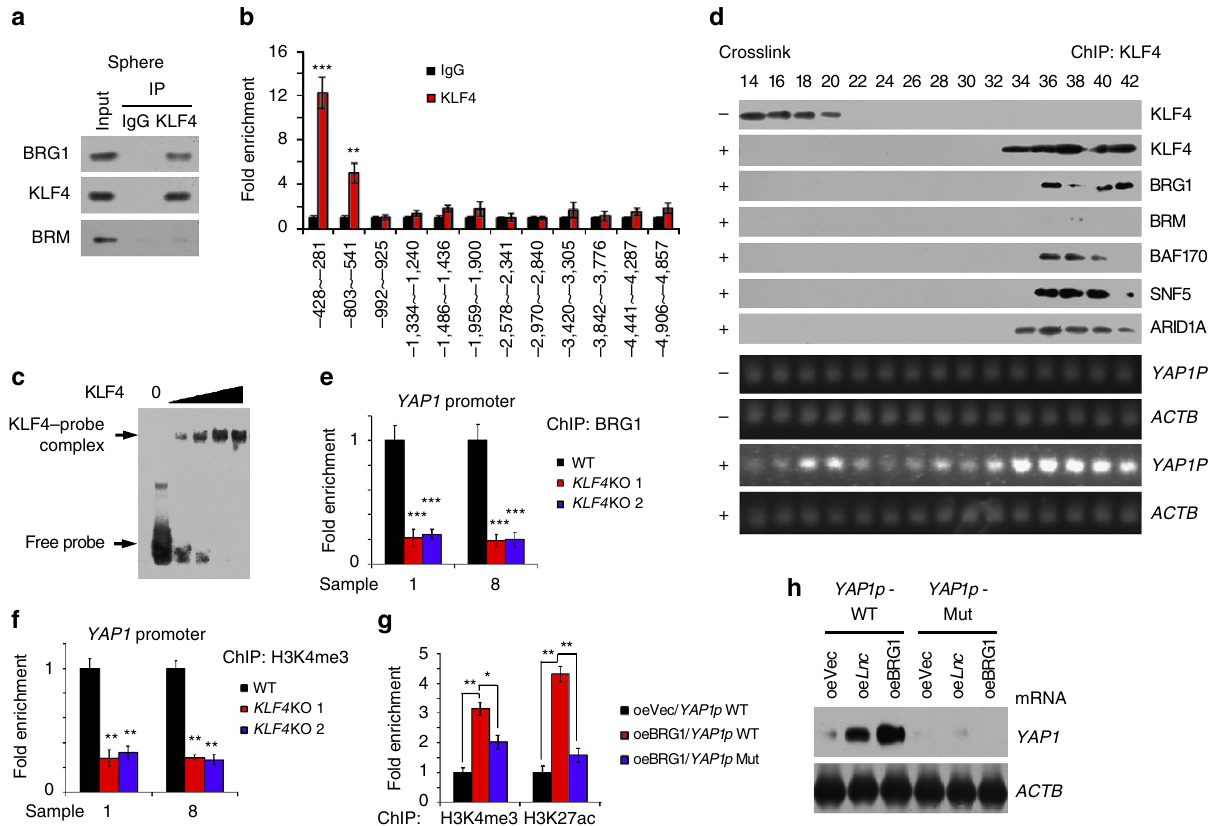
Figure 5 | KLF4 binds YAP1 promoter and recruits the BRG1-embedded BAF complex to initiate YAP1 expression. ( a ) HCC primary spheres were collected for co-IP assays with KLF4 antibody. ( b ) ChIP assay was performed using Klf4 antibody. ( c ) The interaction of KLF4 with YAP1 promoter was verified by EMSA assay. ( d ) HCC primary sphere cells were crosslinked with formaldehyde for ChIP assay with KLF4 antibody, followed by glycerol gradient ultracentrifugation. Elution gradients were concentrated for western blotting (upper panels) and PCR (lower panels) analyses. ( e , f ) KLF4 KO cells were established using CRISPR/Cas9 technology and allowed for sphere formation, followed by ChIP assay using BRG1 ( e ) and H3K4me3 ( f ) antibodies. ( g ) BRG1 was overexpressed in YAP1 promoter mutant ( YAP1p Mut) and wild-type (WT) cells, followed by sphere formation. Oncosphere cells were used for ChIP assays with H3K4me3 and H3K27ac antibodies, followed by examination for YAP1 promoter enrichment with real-time PCR. ( h ) LncBRM or BRG1 was overexpressed in YAP1 promoter mutant and WTcells and collected for RNA extraction. YAP1 mRNA expression was detected with northern blotting. ACTB served as a loading control. Data are shown as means ± s.d. Two-tailed Student’s t -test was used for statistical analysis; * P o 0.05, ** P o 0.01 and *** P o 0.001. Data are representative of three independent